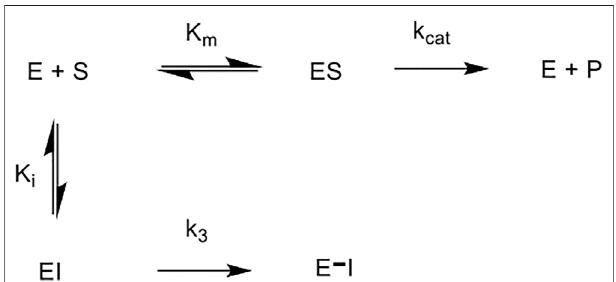
FIGURE 7 | Scheme for irreversible inhibition. E: Enzyme, S: Substrate, ES: Enzyme-Substrate constant, P: Product, EI: Enzyme-Inhibitor complex, K m : Michaelis-Menten constant, K i : Inhibition constant, k cat : catalytic constant, k 3 : fi rst order rate constant, E – I: irreversible enzyme-inhibitor complex.